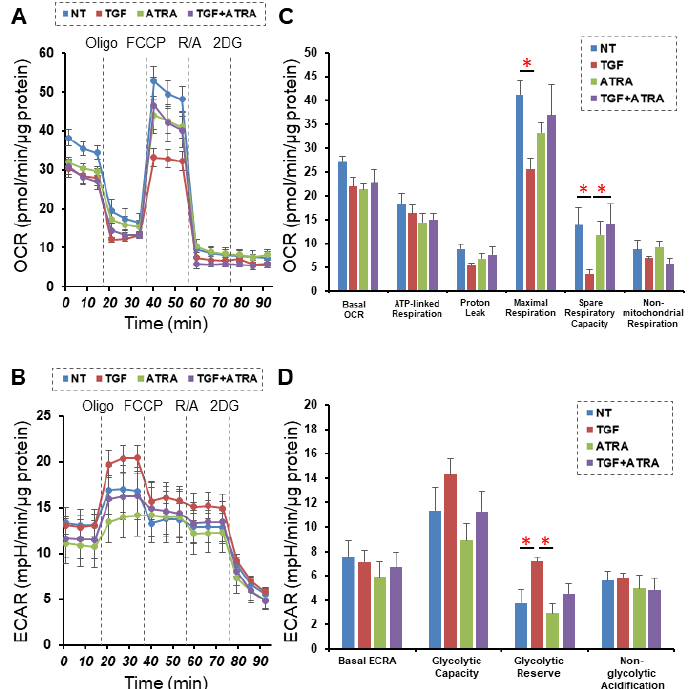
Figure 2. Effects of all- trans retinoic acid (ATRA) on a real-time cellular metabolism analysis of 2D-cultured HTM cells. Two-dimensionally cultured HTM cells untreated (NT—nontreated control) or treated with TGF- β 2 (TGF, 5 ng/mL) and/or ATRA (10 µ M) were subjected to a real-time metabolic function analysis using a Seahorse XFe96 Bioanalyzer. Panel ( A , B ): simultaneous measurements of OCR ( A ) and ECAR ( B ) at baseline and those subsequently supplemented with Oligo (a complex